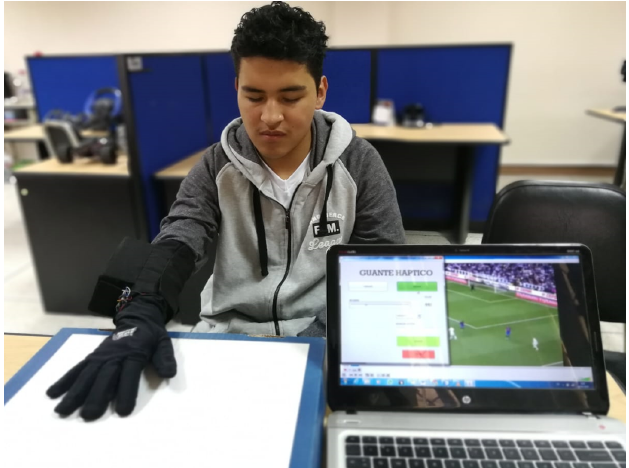
Figure 12. Haptic glove being used by a blind